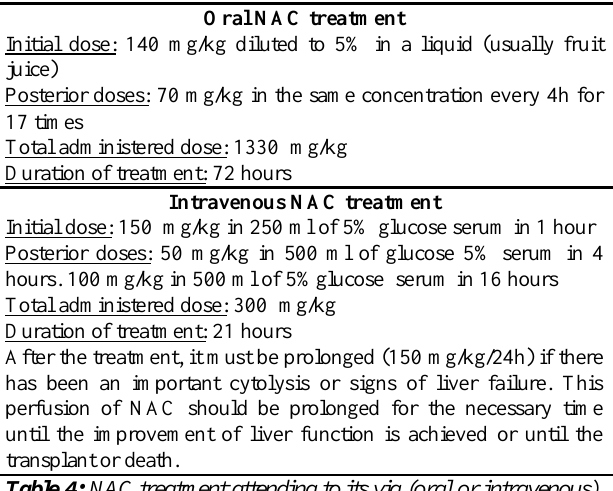
Table 4: NAC treatment attending to its via (oral or intravenous). NAC: